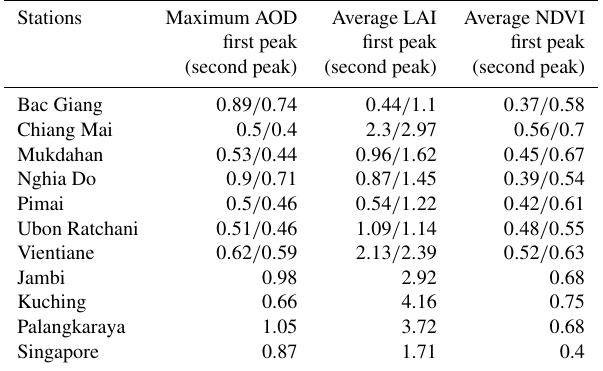
Table 3. Average values of maximum AOD and average LAI and NDVI during the two annual AOD peaks over the northern region for the 2001–2013